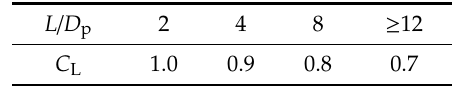
Table 2. Values of parameter C L